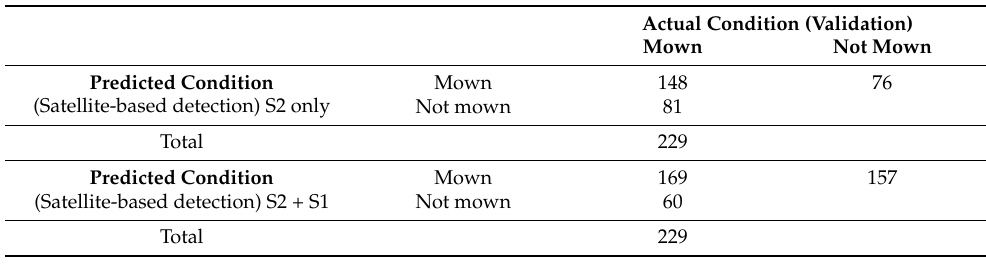
Table 2. Accuracy matrix of detected mowing events showing successfully detected, missed events, and false positives for the focal region in the Ammer catchment area.